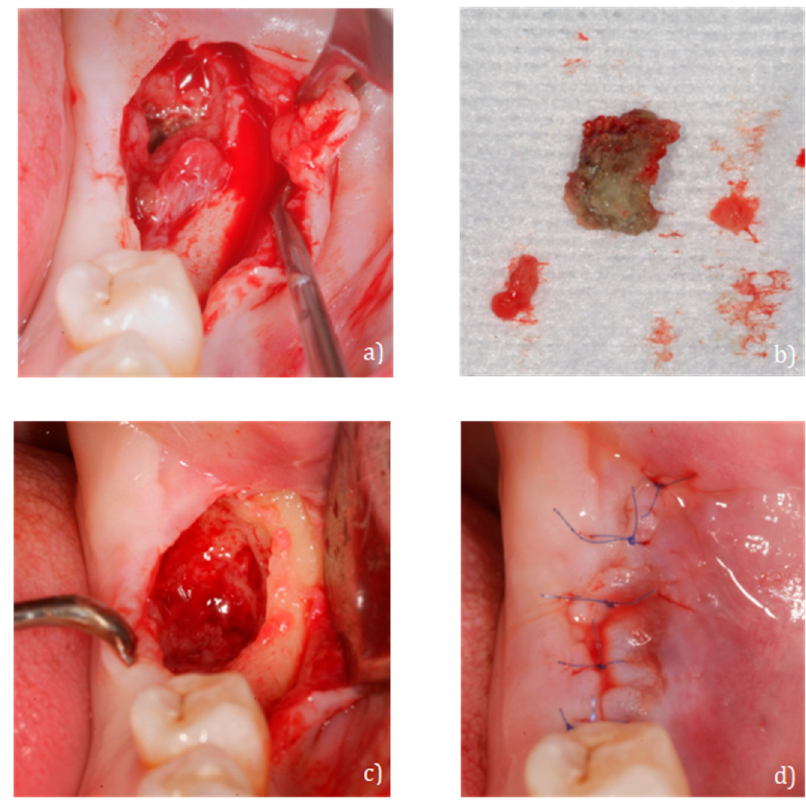
Figure 5. ( a ) Full thickness flap, ( b ) fragment extracted from necrotic bone, ( c ) surgical bed after curettage and irrigation and ( d ) monofilament suture 7/0.